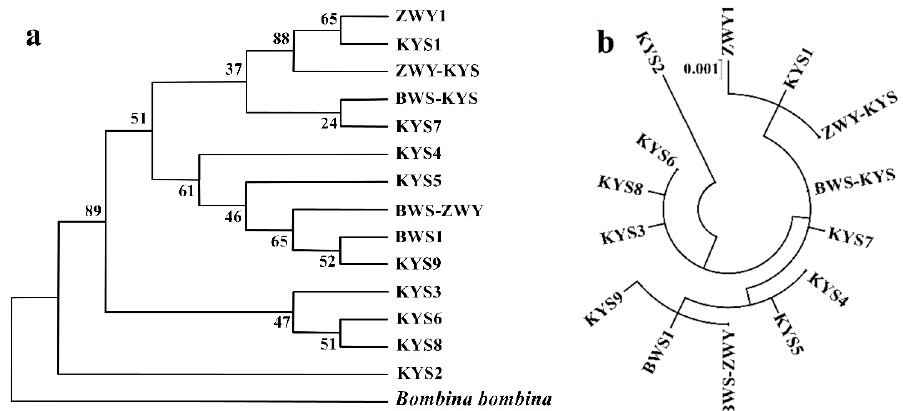
Figure 1. Phylogenetic tree based on mtDNA D ‐ loop region haplotypes. ( a ): Neighbor joining tree. ( b ): Maximum likelihood tree. Confidence degrees on the node were calculated by 1000 bootstraps, and only figures greater than 50% are shown.